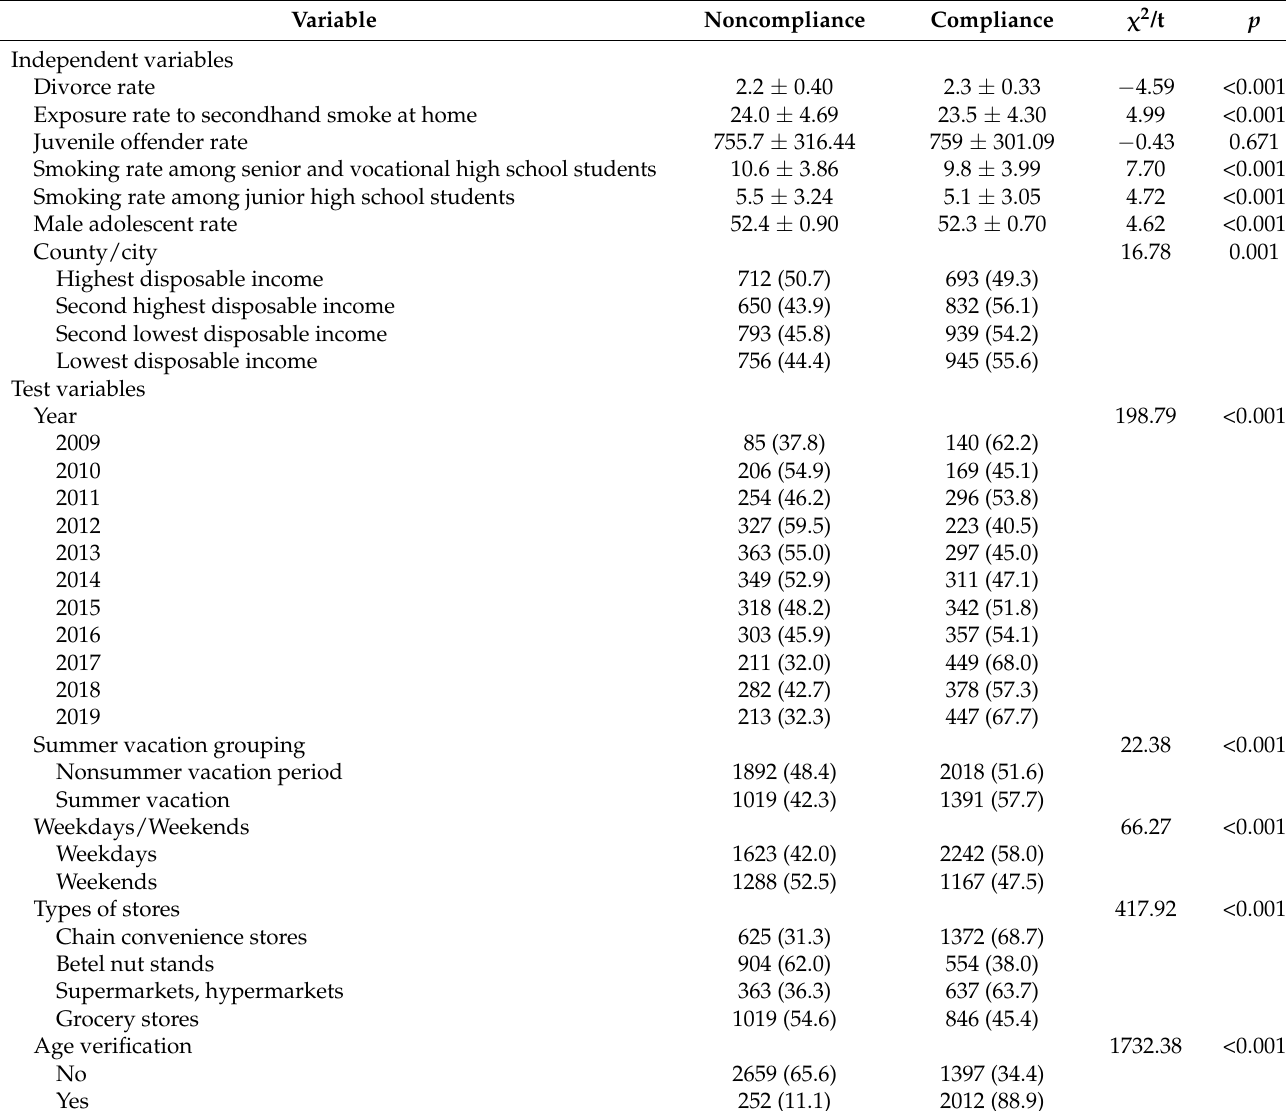
Table 1. Association between independent variables and test variables and test